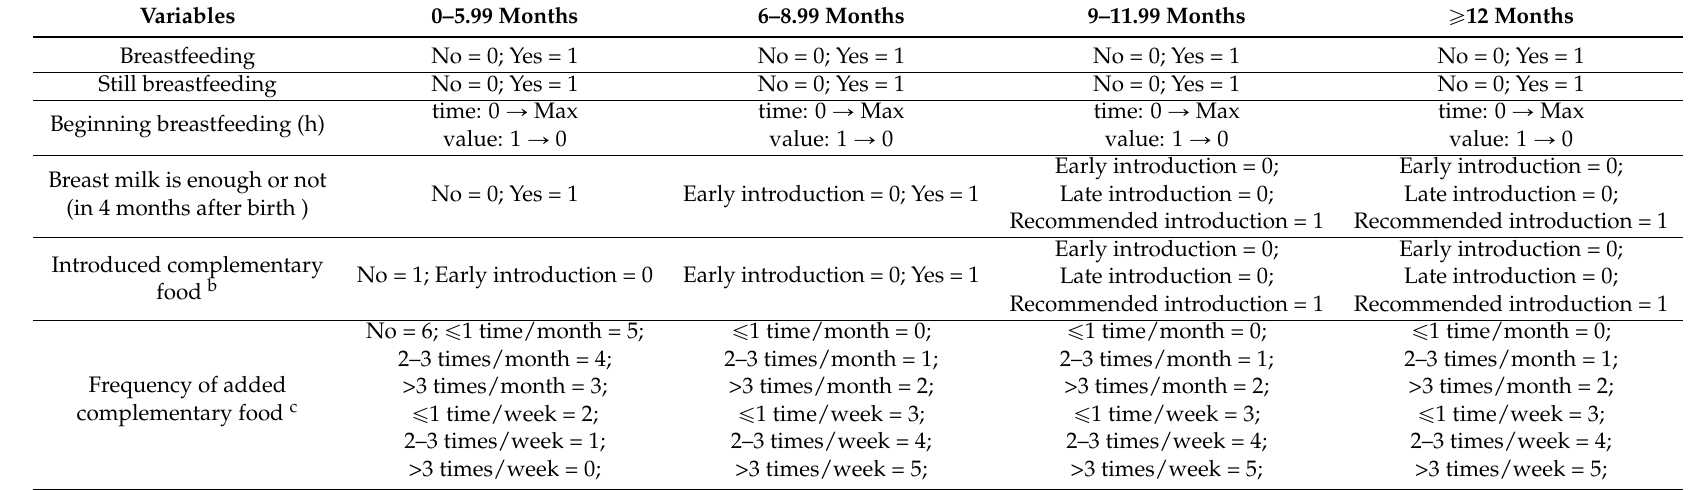
Table 2. Variables and value used to create the feeding practices index by the Rank Sum Ratio (RSR) according to infant’s age distribution a .